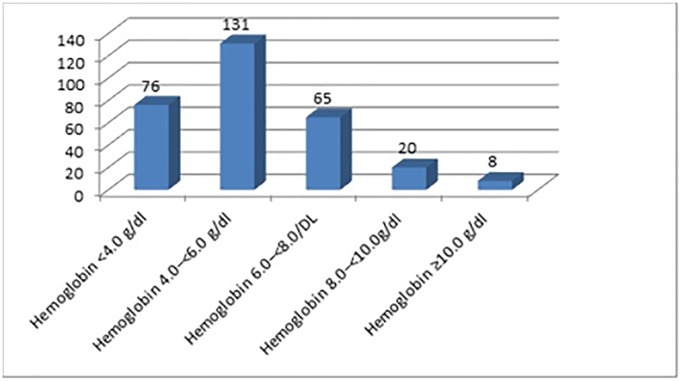
Distribution of hemoglobin level of the transfused children.